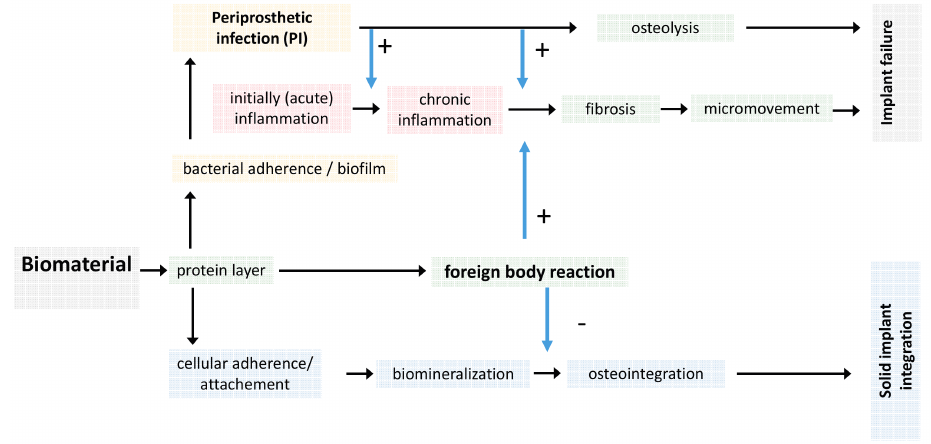
Figure 2. Local and systemic response after biomaterial application. The type of biomaterial and its surface structure dominantly influence osteointegration whereas an initial acute inflammatory reaction occurs independently and is based on the local surgical